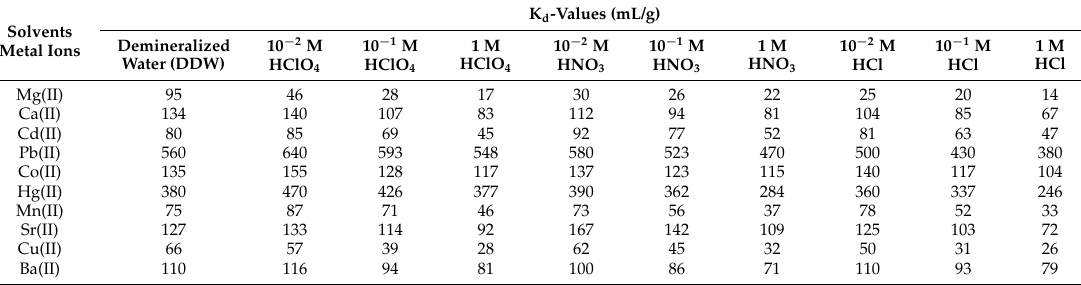
Table 5. K d -values of some metal ions on graphene Th(IV) phosphate column in different solvent systems.